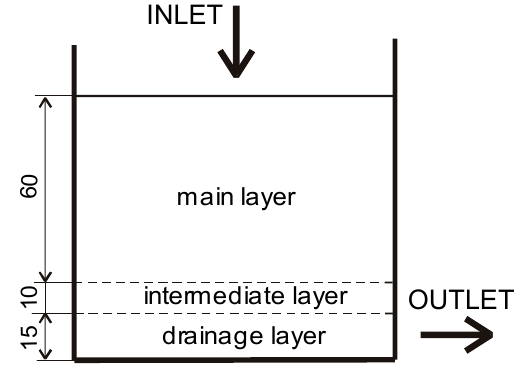
Figure 1. Schematic representation of the indoor VF pilot ‐ scale wetland (values are in cm).